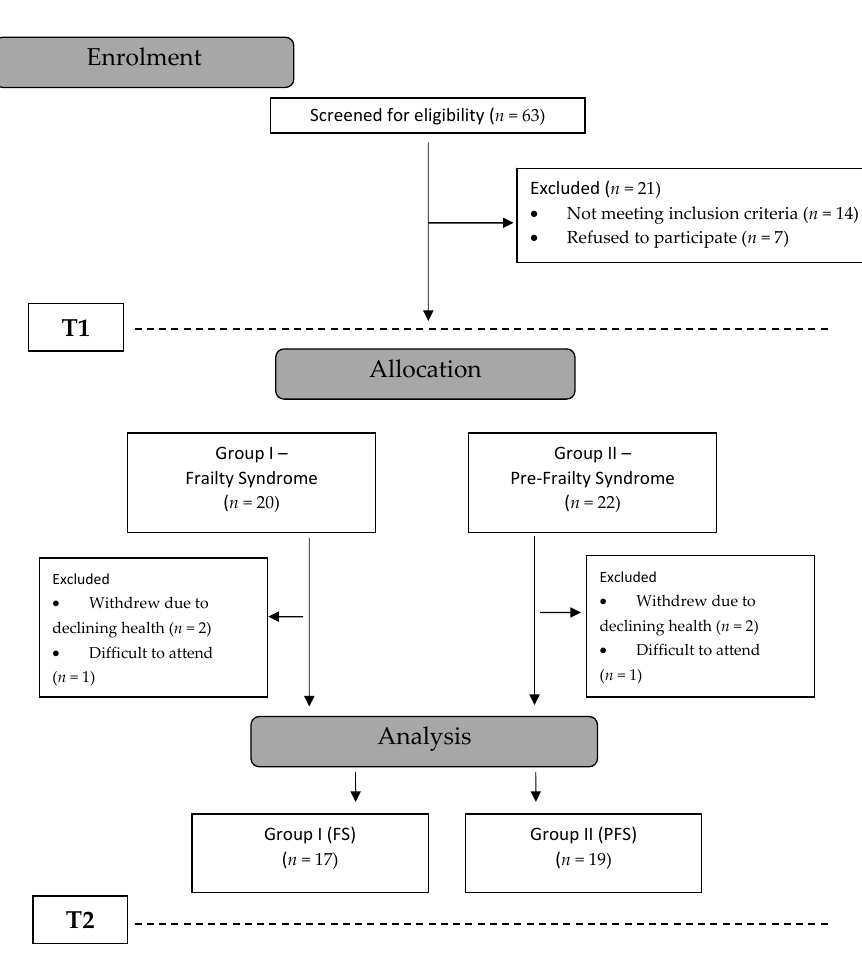
Figure 1. Design and flow of participants throughout the study.